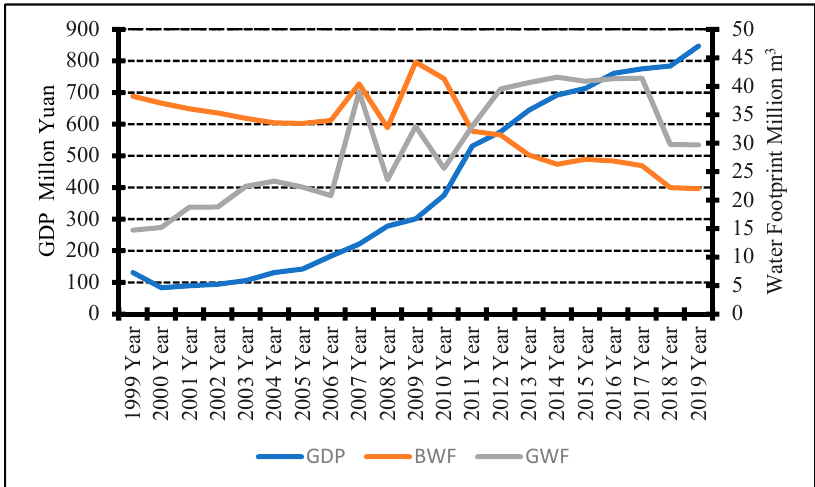
Figure 1. The trend of E and WF in Yangling from 1999 to 2019.